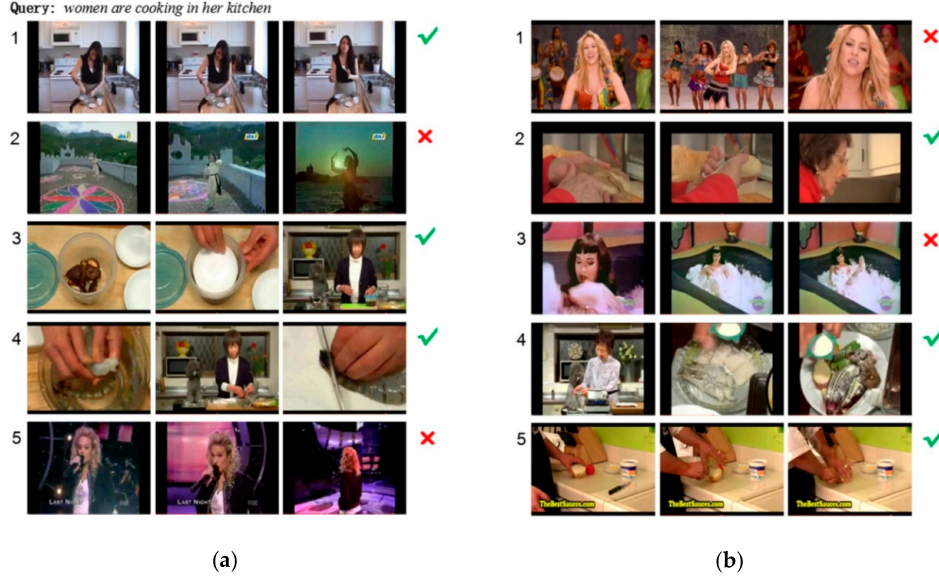
Figure 6. Top five video shots returned on MSVD dataset with a query. ( a ) is our method and ( b ) is √ dual encoding. The video clip with in green means correct result, with × in red means error.